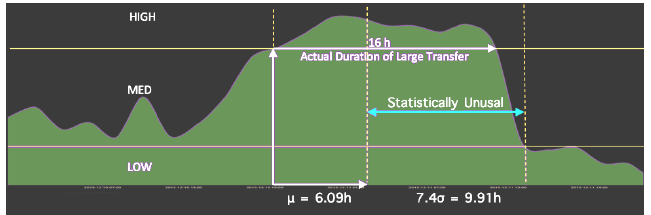
Figure 10. Network bandwidth utilization